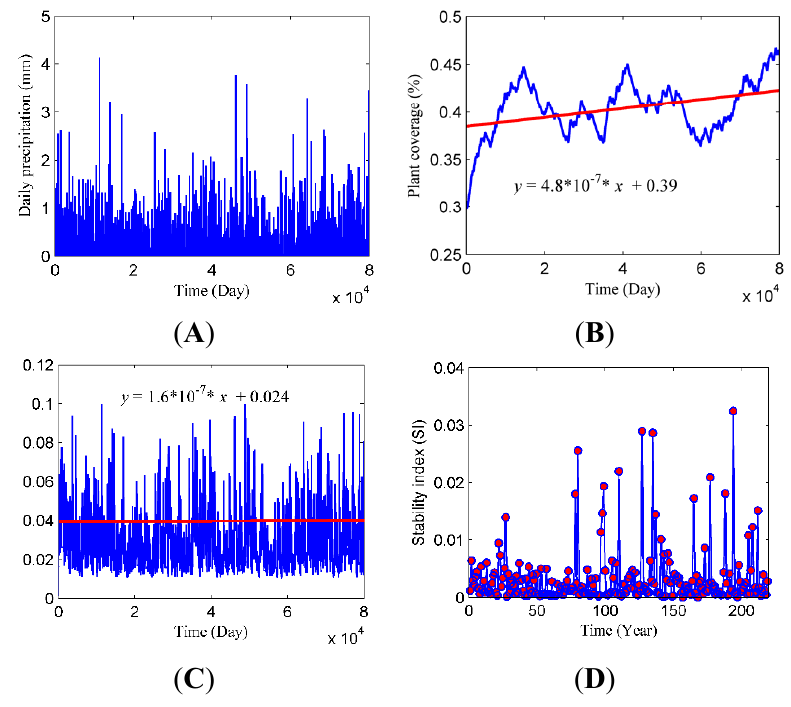
Figure 4. ( A ) Simulated results of daily precipitation; ( B ) plant coverage; ( C ) soil moisture and ( D ) stability index using Equation (1) over 219